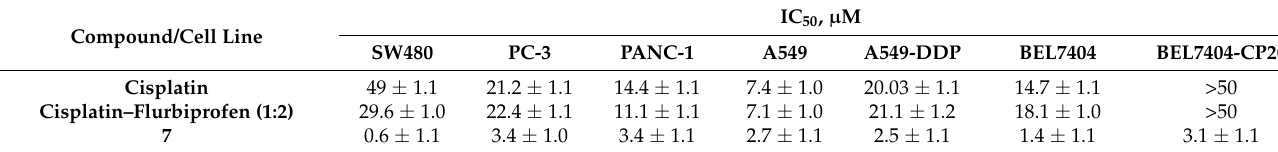
Table 7. Antiproliferative activity of Pt(IV) prodrug 7 on SW480 (colon adenocarcinoma), PC-3 (prostate adenocarcinoma), PANC-1 (pancreatic cancer), A549, A549-DDP (lung carcinoma), BEL7404 (liver carcinoma), and BEL7404-CP20 (cisplatin- resistant liver carcinoma) cell